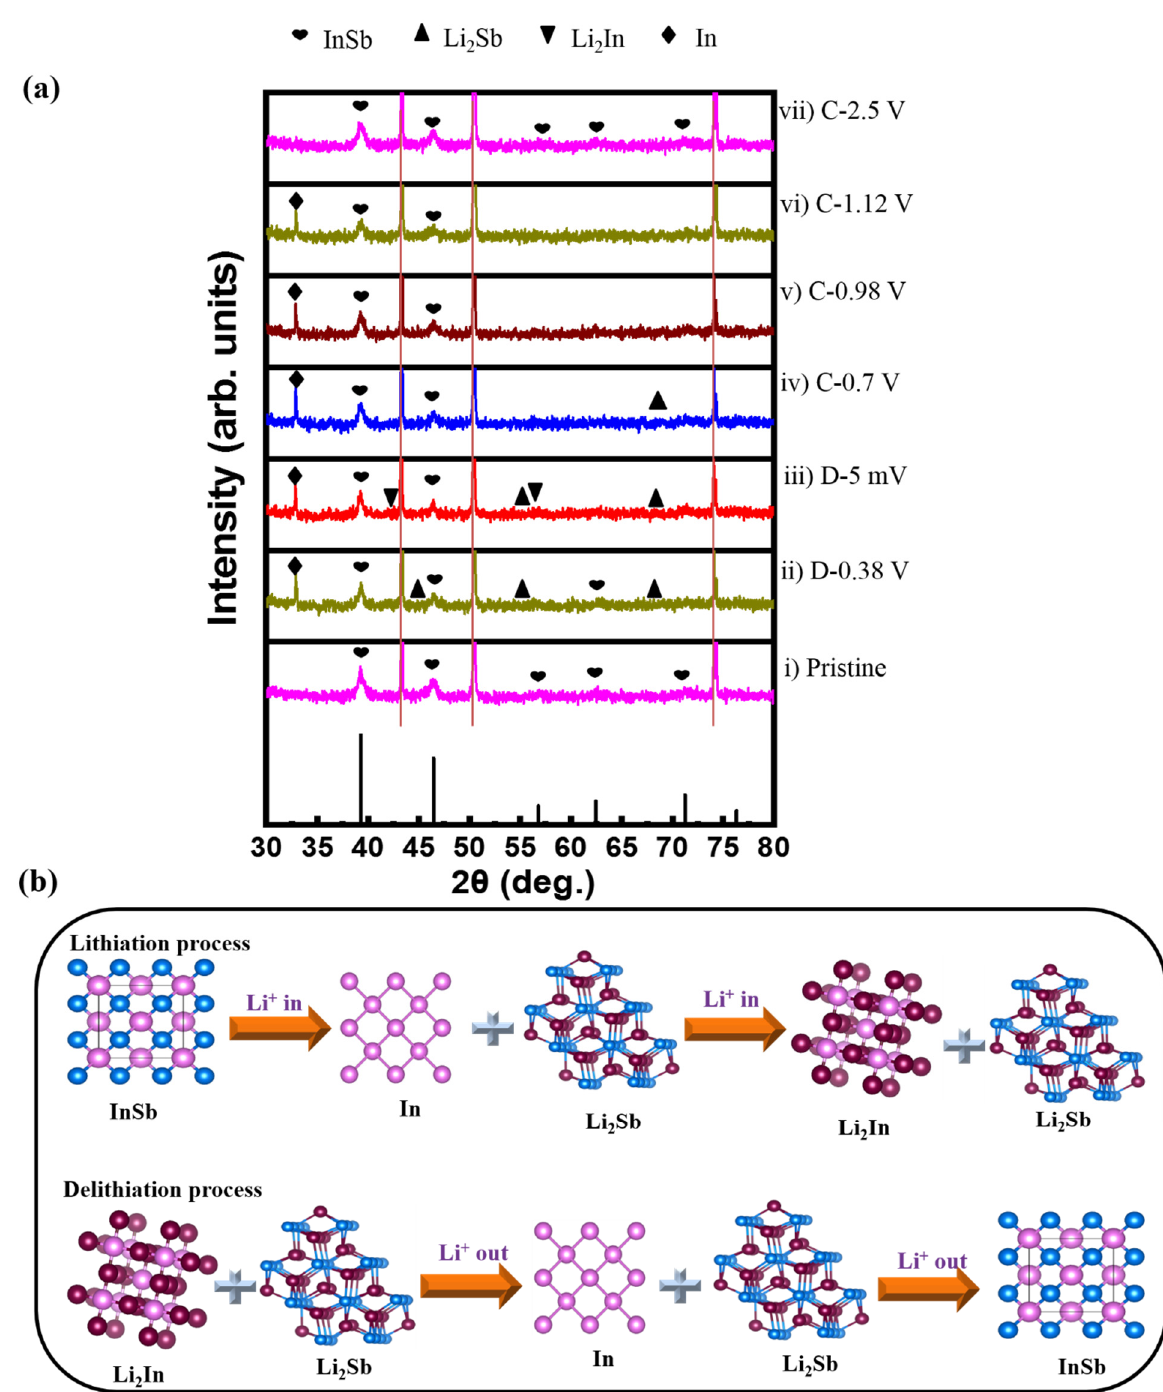
Figure 4. ( a ) XRD patterns collected at selected potential states in the initial lithiation/delithiation process. ( b ) Schematic of the electrochemical reaction mechanism of the InSb_PAA electrode during cycling.